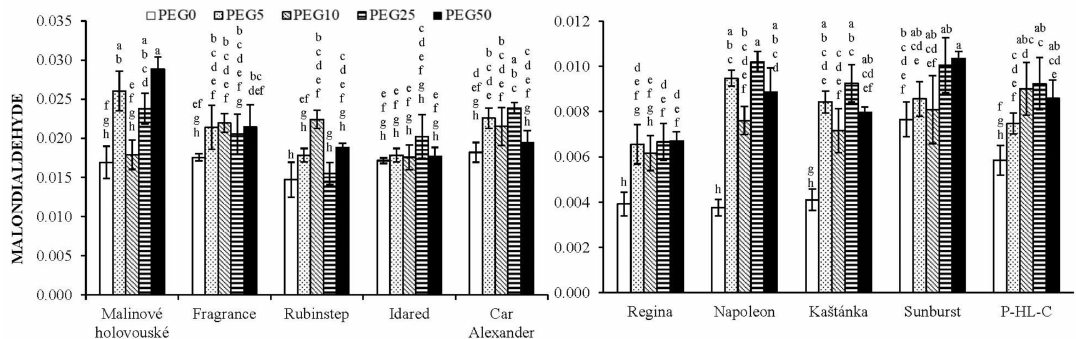
Figure 5. E ff ect of di ff erent PEG-6000 concentration on content of malondialdehyde ( µ mol g − 1 FW) in in vitro culture of apple and cherry cultivars. Error bars represent means ± SDs (n = 3). Values within column, followed by the same letter(s), are not significantly di ff erent according to Tukey’s test ( p <